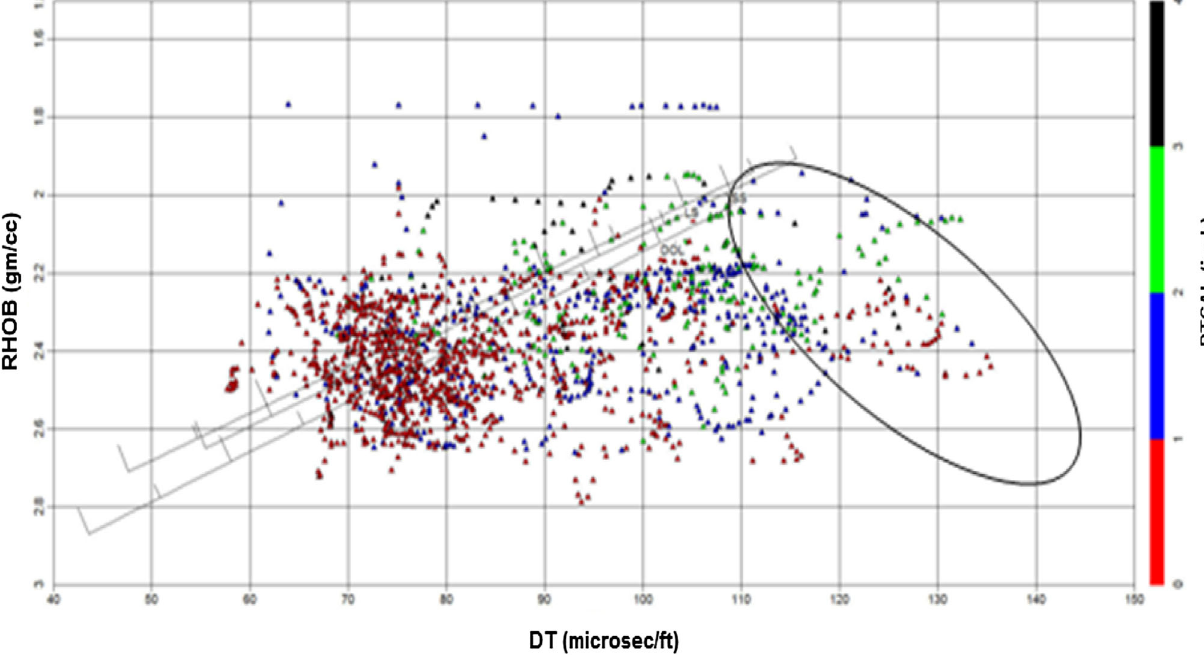
Fig. 3 Cross-plot between RHOB and DT colored by differential caliper (data falling within the marked circle represent erroneous